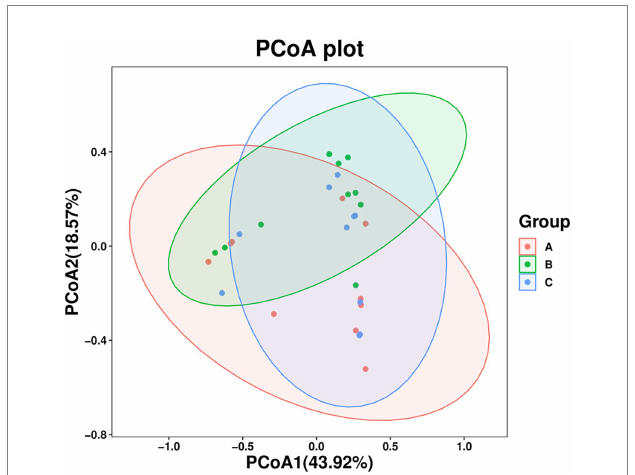
FIGURE 3 Principal coordinates analysis (PCoA) of wild Arborophila rufipectus and Lophura nycthemera gut microbial communities. A dot represents all samples, and distinct colors represent distinct groups.